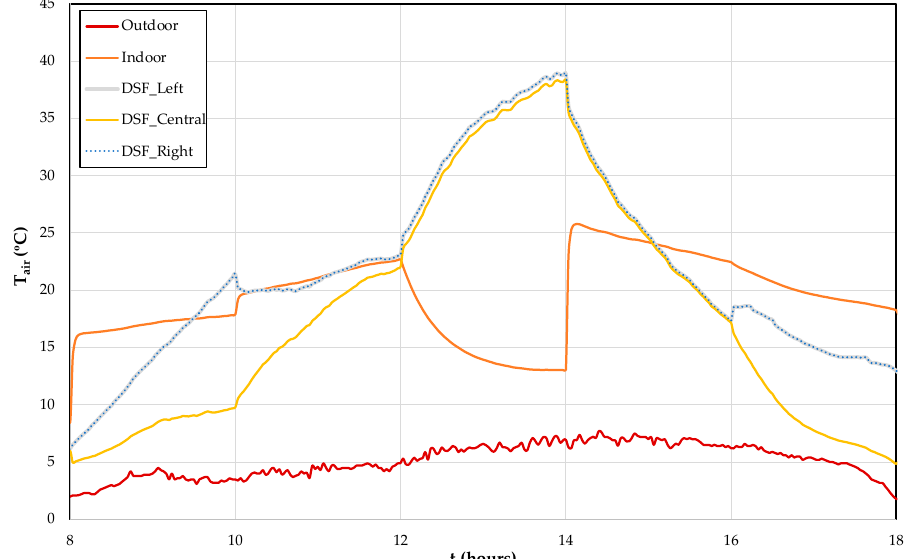
Figure 14. Evaluation of air temperature (T air ) of the outdoor environment, indoor virtual chamber and indoor left, central and right DSF system, when the airflow rate is constant and the number of DSFs to operate is variable, for the Case B.